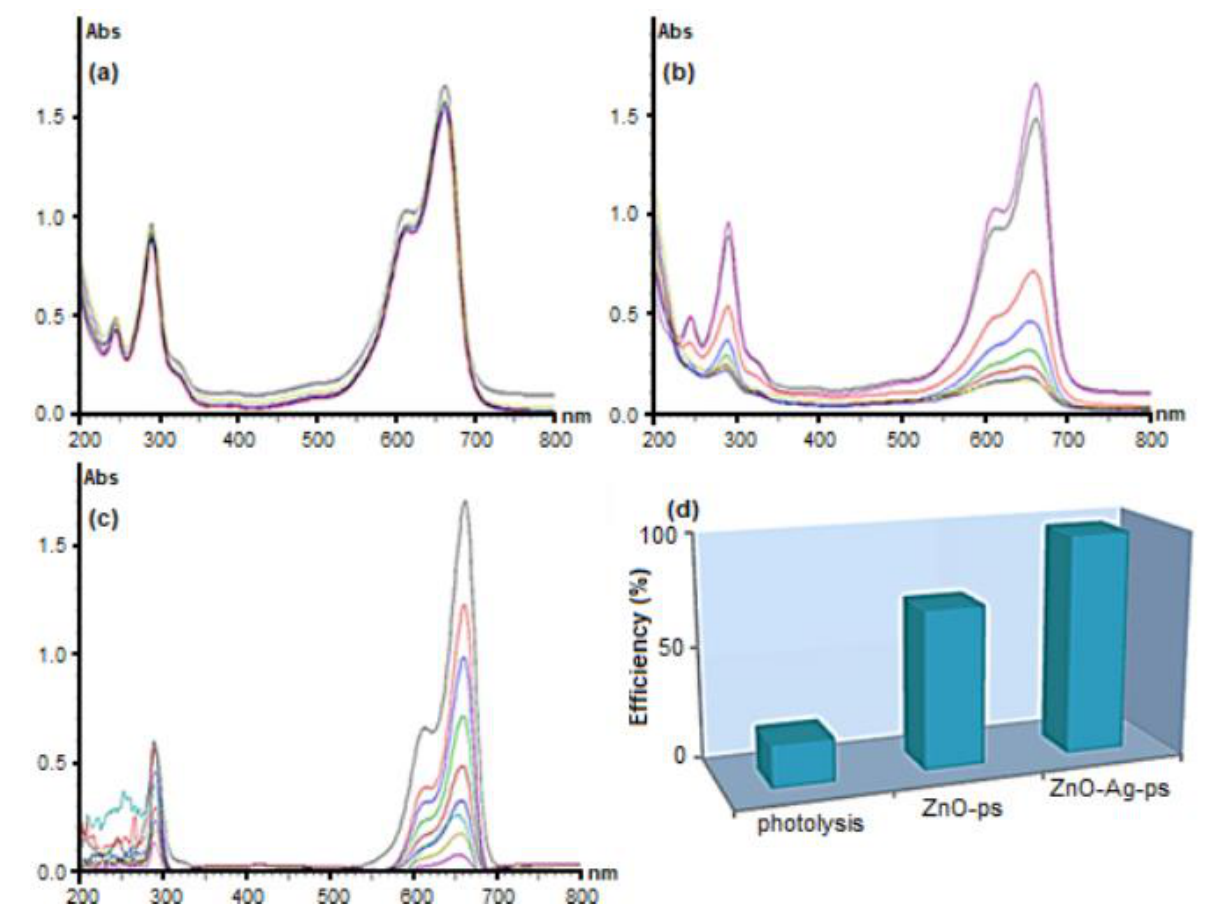
Figure 8. Photodegradation activity of methylene blue (MB). ( a ) PS sample, ( b ) ZnO/PS composite, ( c ) ZnO-Ag/PS film, and ( d ) efficiency of photodegradation. Reprinted from [57].